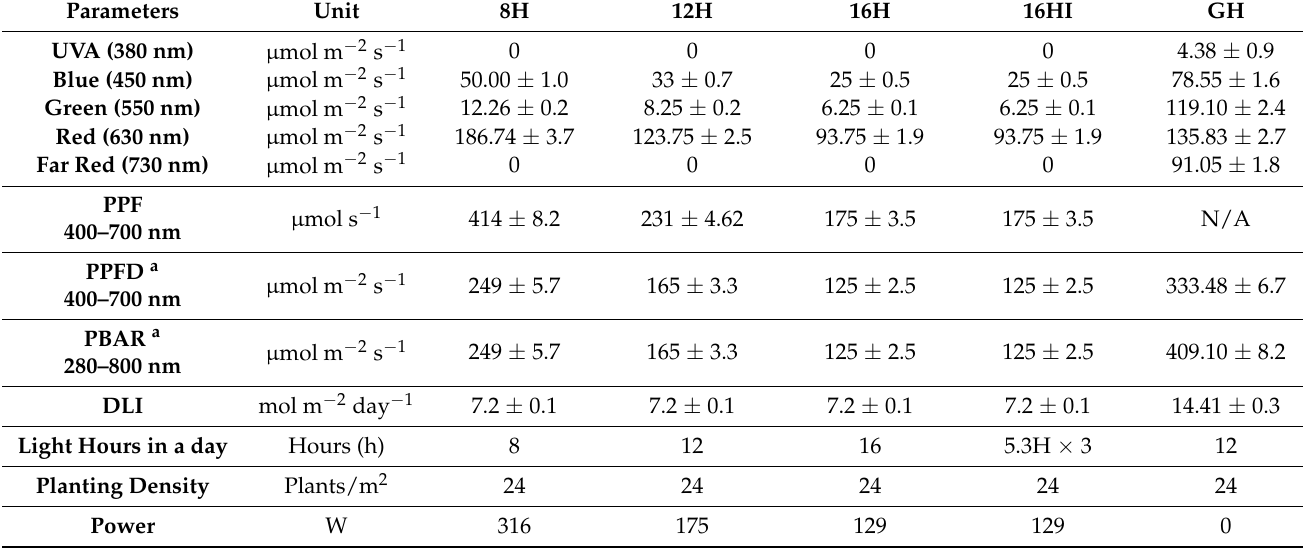
Table 1. Light treatments of photoperiod